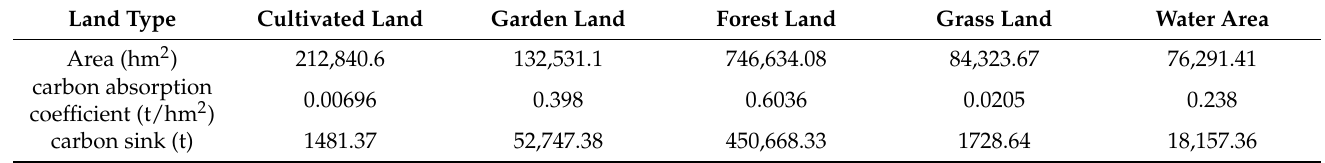
Table 3. Area, carbon absorption coefficient, and carbon absorption of land in Beijing.